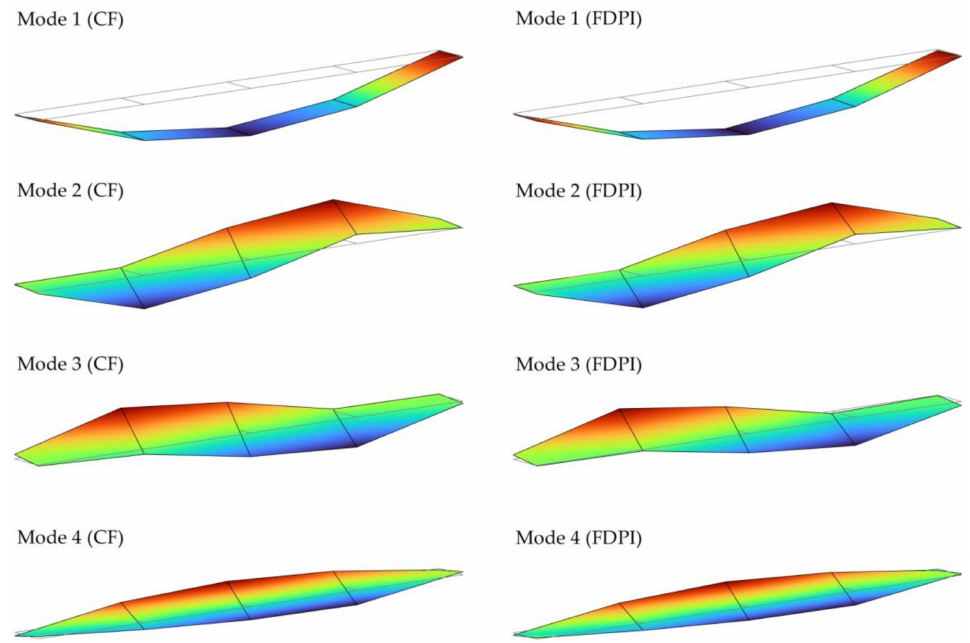
Figure 9. Mode shapes corresponding to modes 1 to 4 estimated by applying both algorithms: CF ( left ) and FDPI ( right